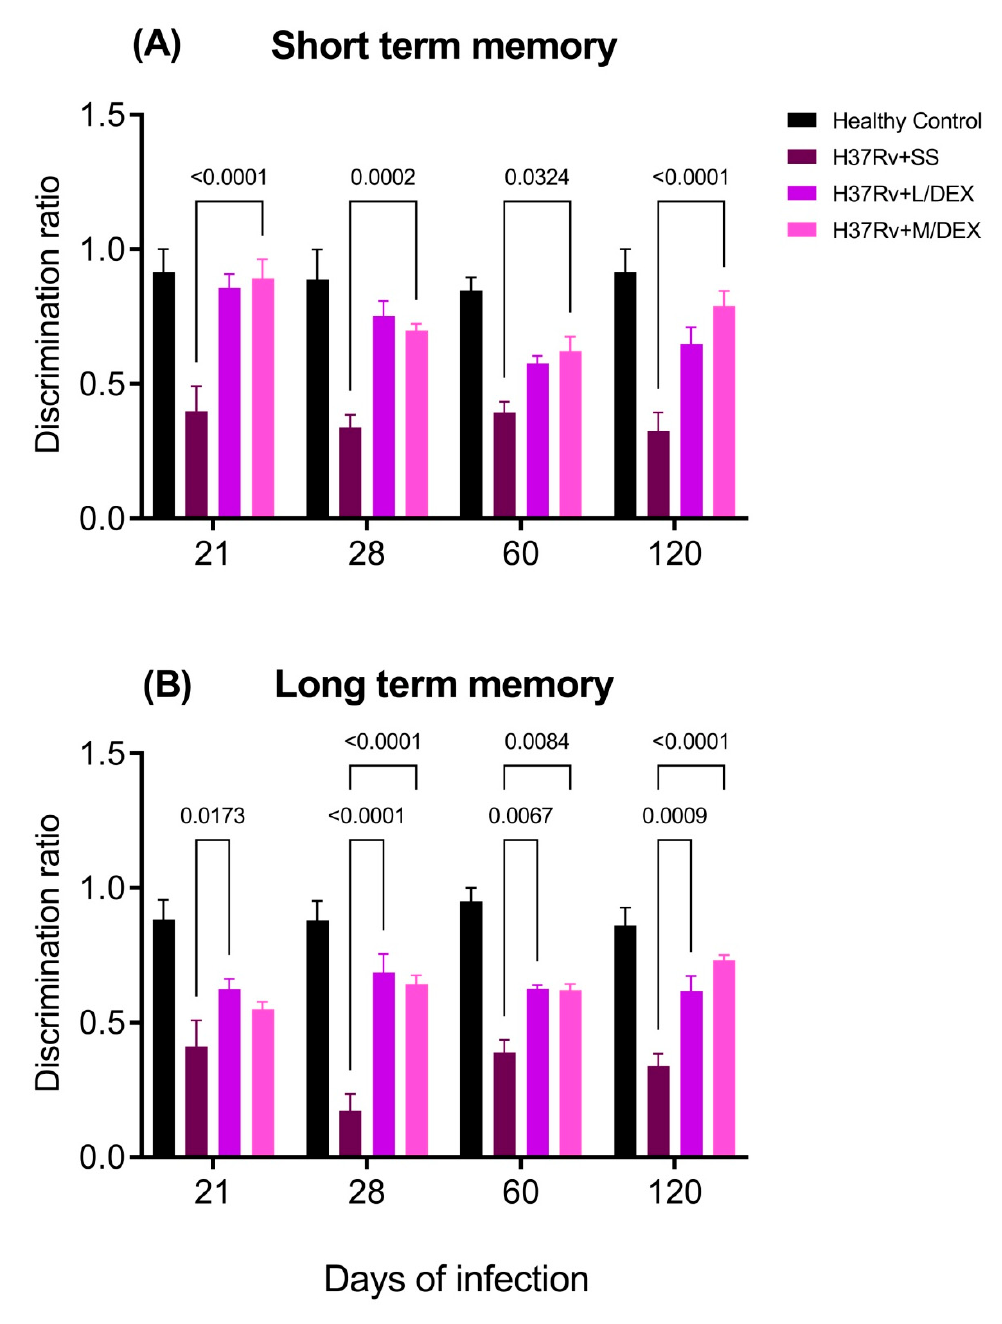
Figure 5. Effect of IN L/DEX (0.05 mg/kg BW) and M/DEX (0.25 mg/kg BW) on TB mice’s memory damage. ( A ) Short-term memory. F (2, 15) = 77.03, p < 0.0001. Two Way ANOVA. Tukey’s multiple comparisons test ( n = 6). ( B ) Long-term memory. F (2, 15) = 50.69, Tukey’s multiple comparisons test ( n = 6). Data are presented as mean +/ − SEM. Animals with TB treated with IN DEX showed a significant improvement in short- and long-term memory.